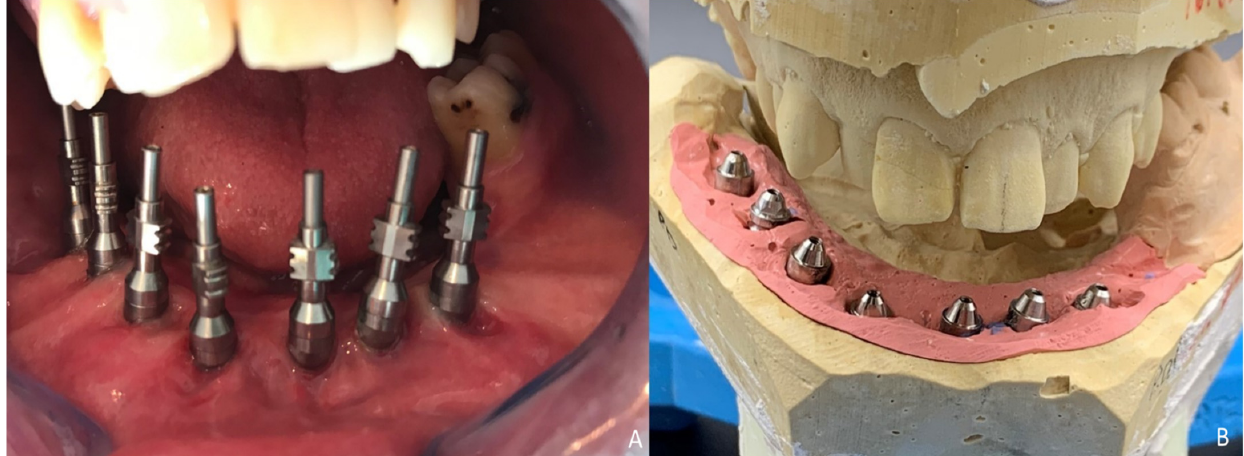
Figure 9. Prosthetic rehabilitation. ( A ) Second-stage surgical procedure and impression copings for dental rehabilitation with successful soft-tissue reconstruction. ( B ) Evaluation of the occlusal vertical dimension and record centric relation.